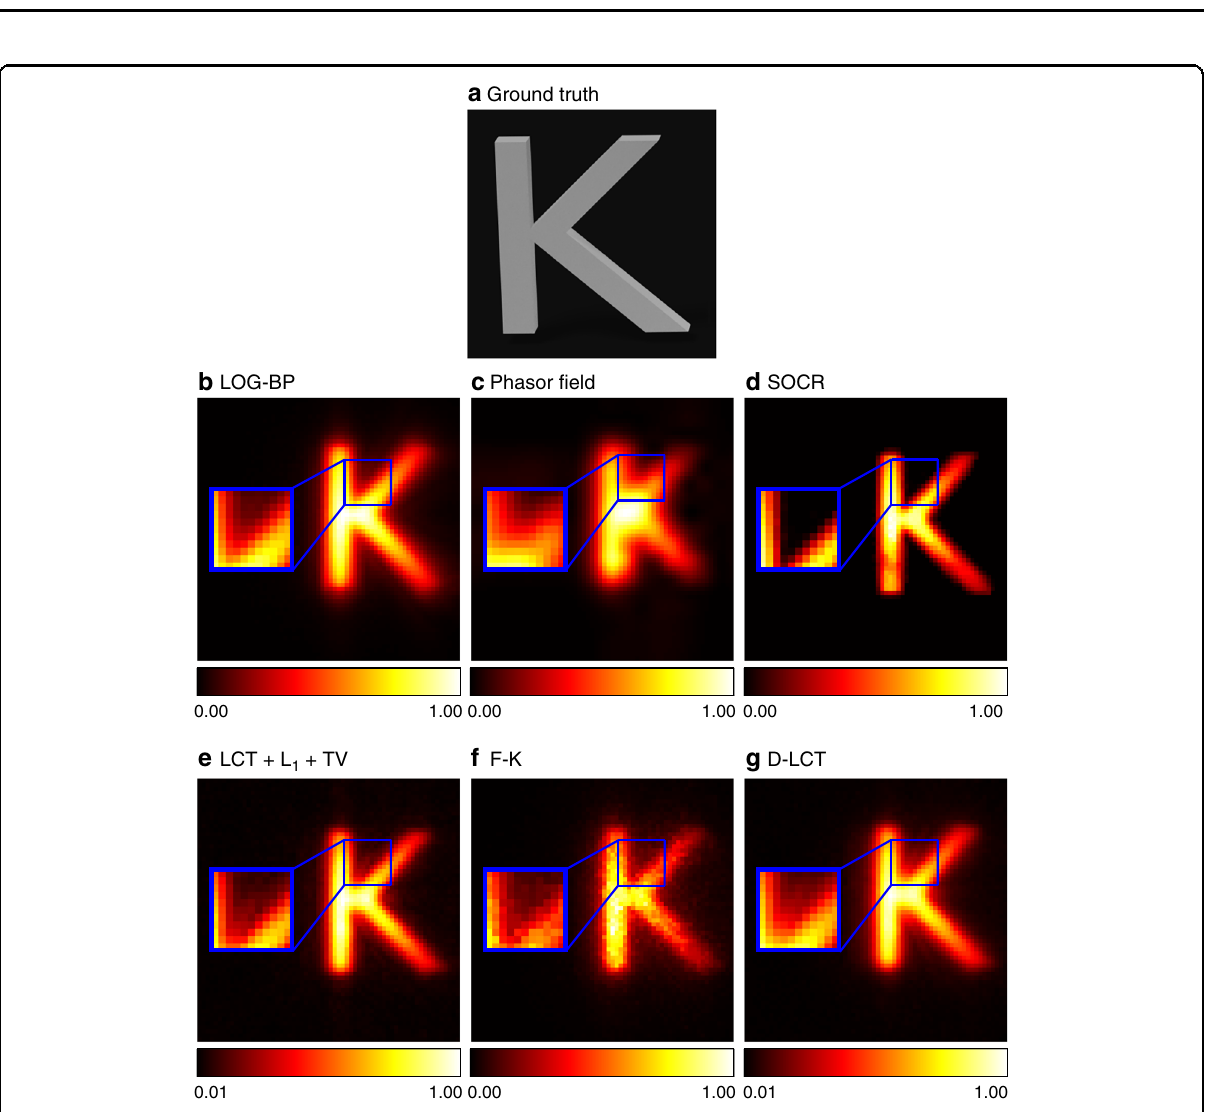
Fig. 7 Reconstruction results of the letter K (non-confocal). The ground truth is shown in a . Reconstructions are shown in b – g . The F-K reconstruction is noisy. The LCT + L 1 + TV and D-LCT reconstructions are blurry and contain artifacts. The phasor fi eld method does not provide a clear reconstruction. The proposed method has the highest contrast and the corners are well